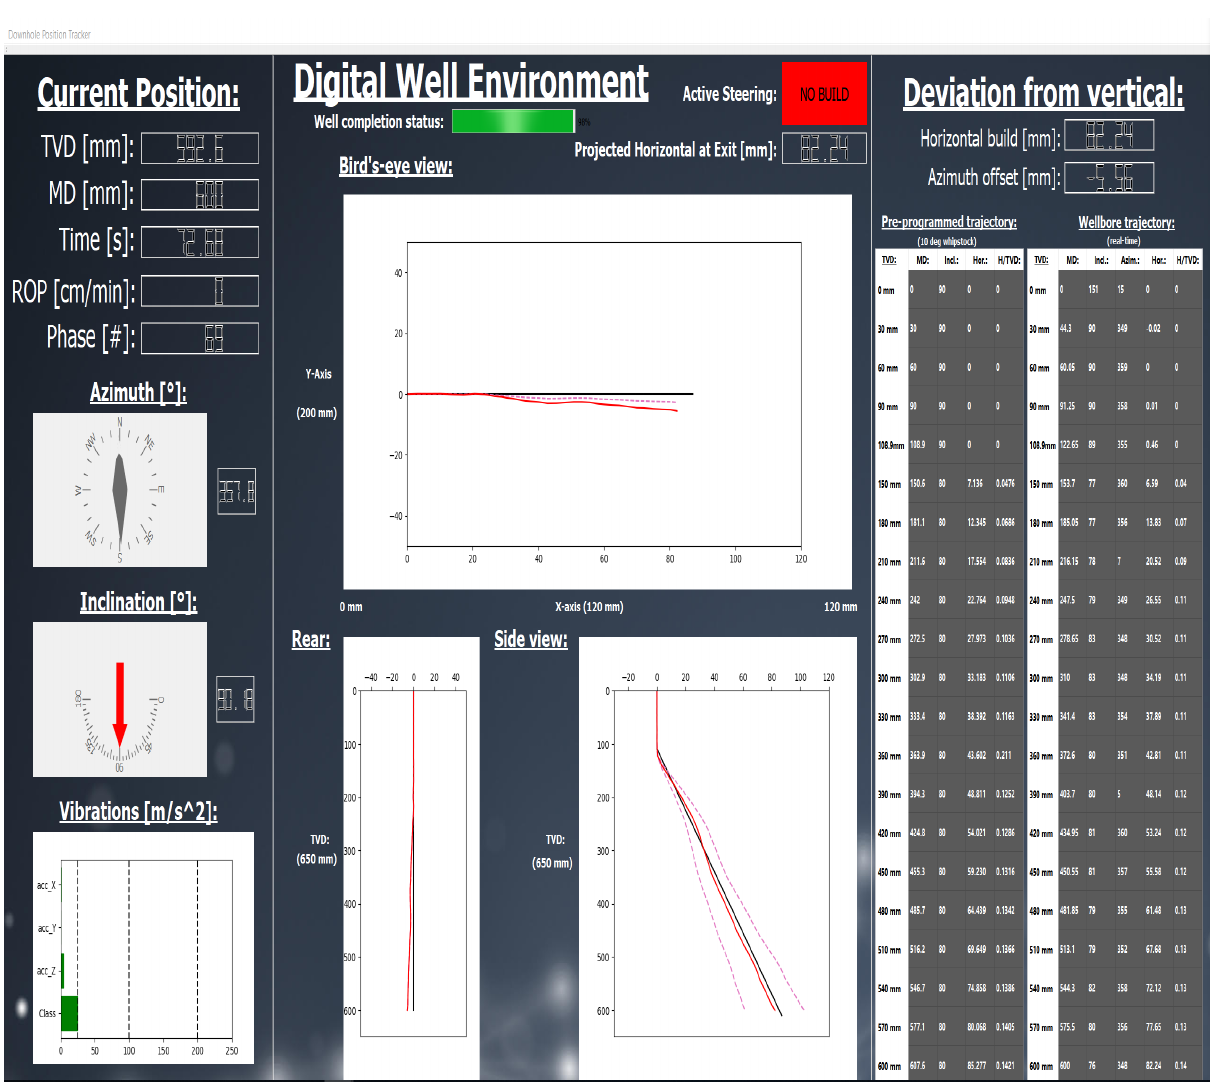
Figure A.2: GUI is equipped with gauges and parameters showing the control system setpoints and sensor feedback as well as building a well log in real-time for interpretation of all stages of the drilling